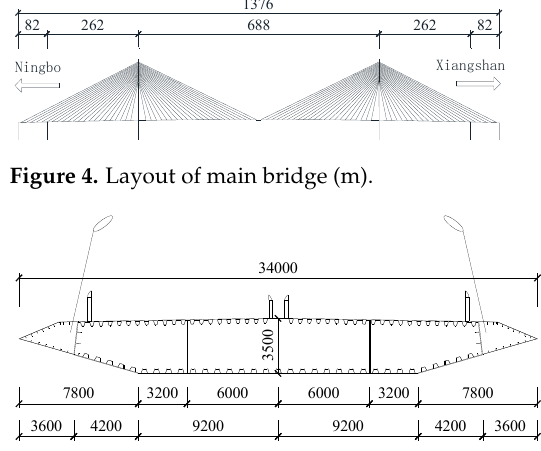
Figure 5. Cross-section layout of steel box girder (mm).